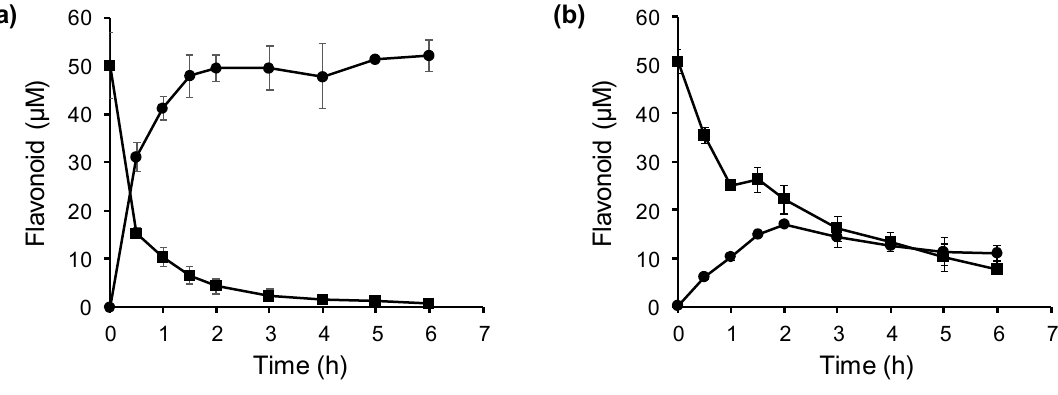
Figure 6. Kinetics of biotransformation of flavonoid substrates ( ) to the corresponding methylated products ( ) using E. coli harboring PfOMT3 . Bioconversions of ( a ) naringenin to sakuranetin, and ( b ) kaempferol to rhamnocitrin, were monitored over time. Results are the means ± SD of three independent experiments.